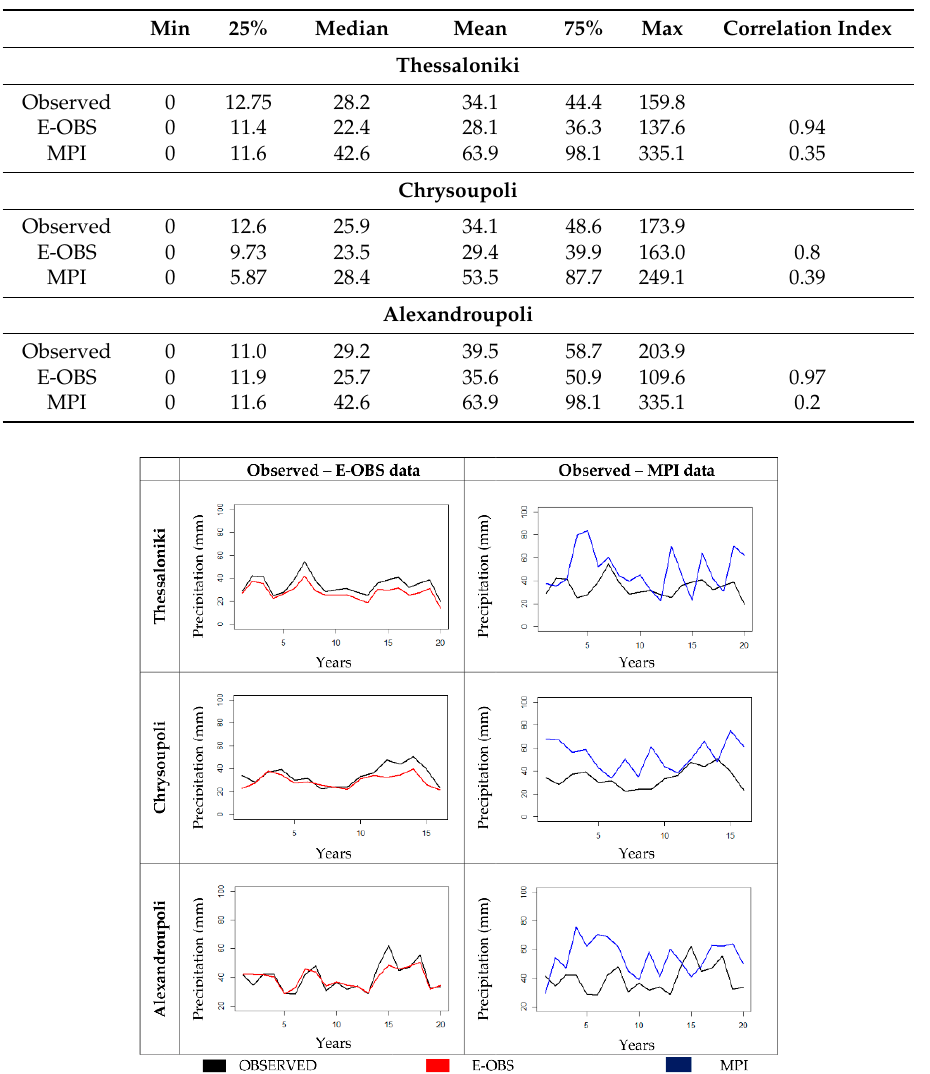
Table 2. Statistical results for observed, E-OBS and MPI datasets in mm. The correlation of E-OBS and MPI was calculated between these datasets and observed datasets.